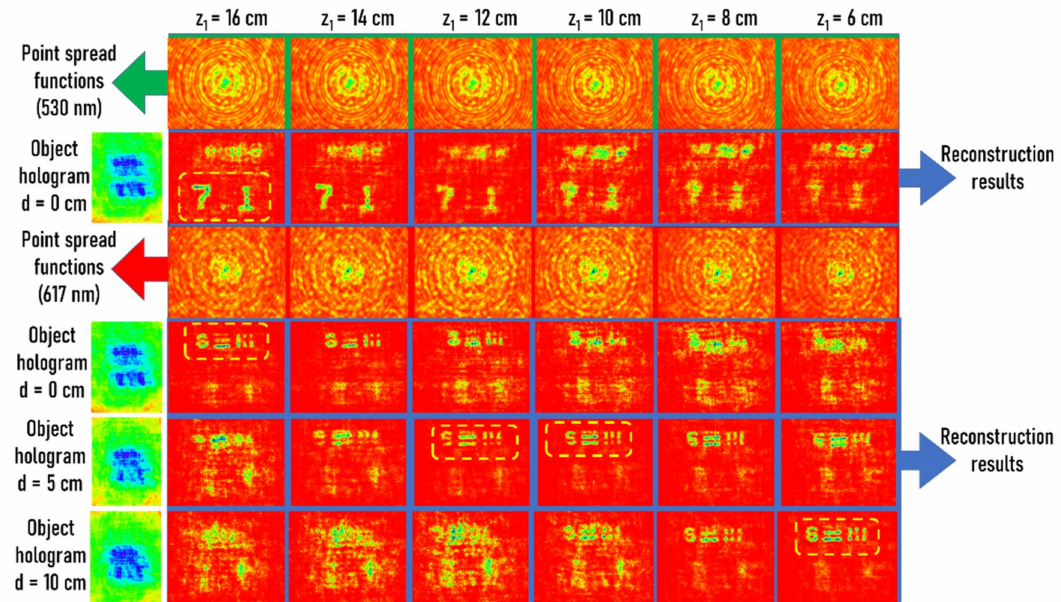
Figure 5. Four-dimensional reconstruction results demonstrated using holograms of two plane objects of di ff erent thicknesses ( d = 0, 5, and 10 cm) and two di ff erent wavelengths. The point spread functions reconstructed the depth-specific and wavelength-specific information with the maximum focus while the information from other planes and wavelengths were blurred with decreased intensities. The blue border lines indicate the reconstruction results. The green border lines and red border lines indicate the point spread function of the green and red wavelengths and the yellow square boxes indicate the cases with the best